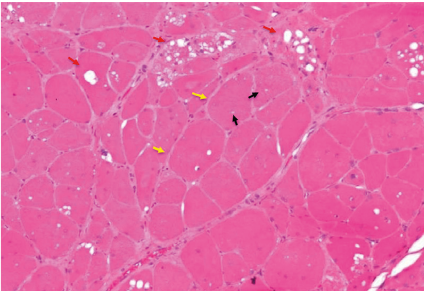
Figure 3: 10x magnification of H&E stained histology specimen of rhabdomyoma shows tightly packed, variously sized, round or polygonal cells separated from one another by thin fibrous septa and small vascular channels (yellow arrows). The cells have eo- sinophilic, striated cytoplasm with occasional intracytoplasmic vesicles (black arrows), vacuoles (red arrows), peripherally placed vesicular nuclei, and one or two prominent nucleoli. Mitotic figures and evidence of necrosis were